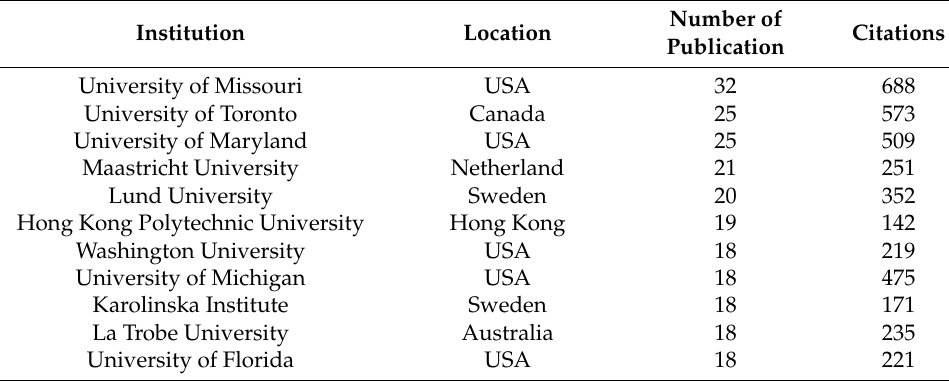
Table 2. The top 11 most productive institutions.